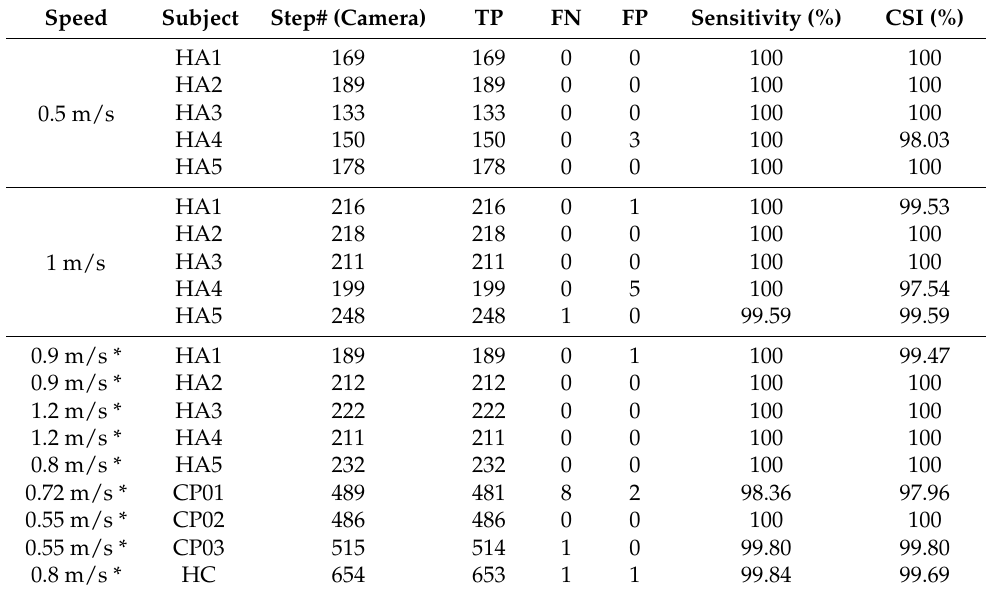
Table 3. Combined trigger signal: five healthy adults (HA) at three different treadmill speeds, in three children with unilateral CP and one healthy child (HC). * preferred speed.